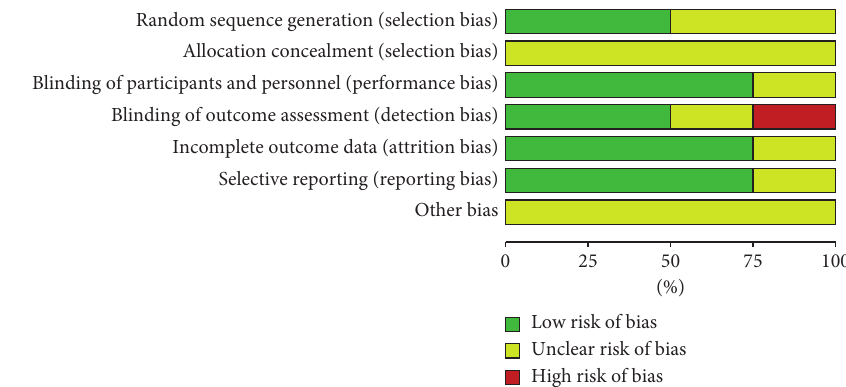
Figure 2: Risk of bias graph for the included randomized controlled